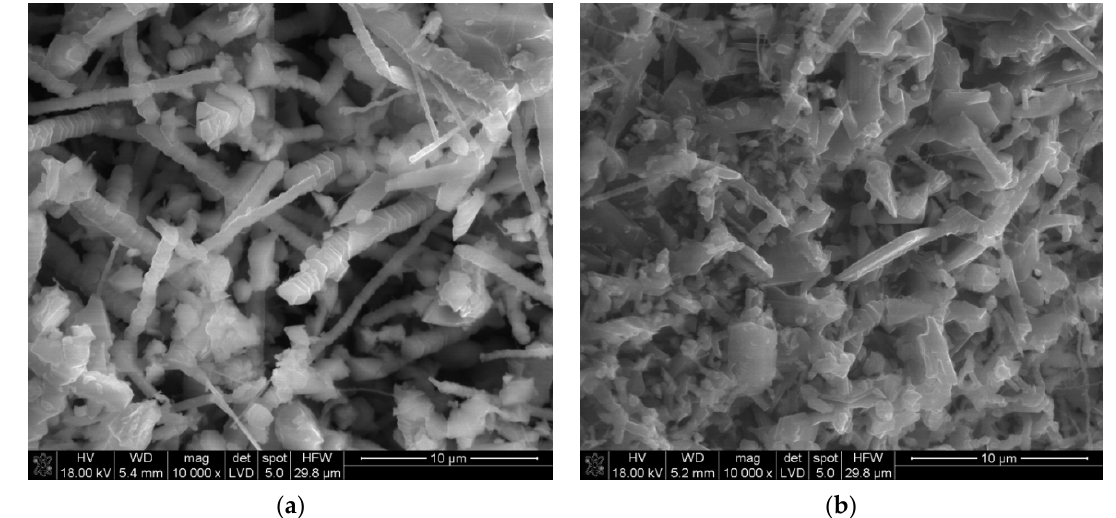
Figure 7. SEM images of powders after SHS, ( a ) medium alumina with Al-63 under 1 MPa, ( b ) coarse alumina with Al-63 under 1 MPa.